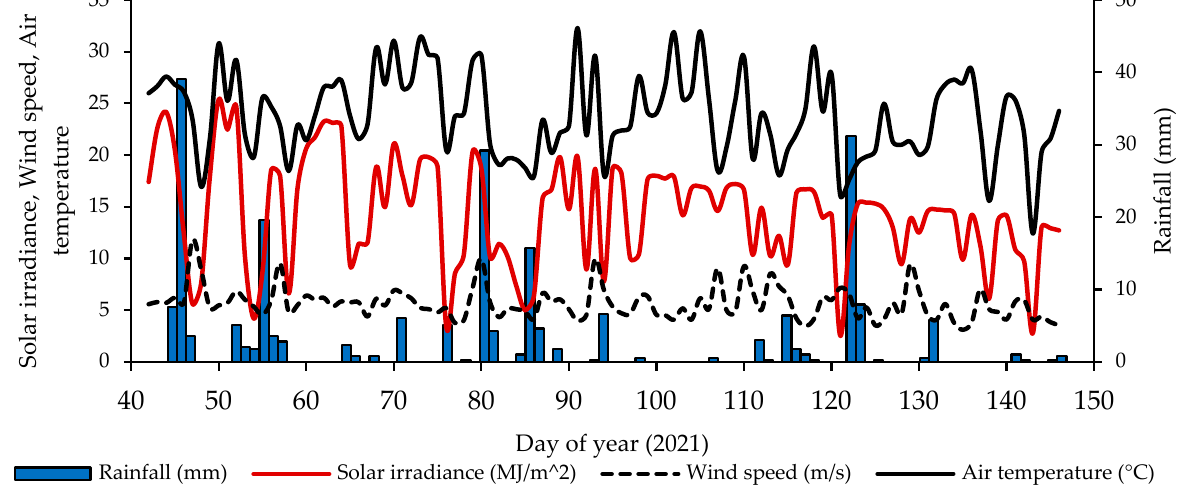
Figure 1. Swayimani weather conditions over the period of maize phenotyping.